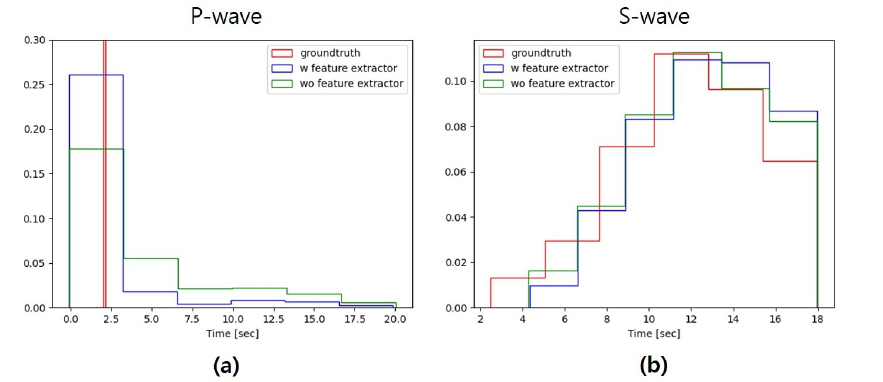
Figure 9. Comparisons of the picked arrival times distribution in the testing dataset. The blue and green histograms indicate the distributions of P- and S- wave arrival times in the synthetic seismic data generated by the architecture with or without feature extractor, respectively. The red histogram indicates those distributions in real data. ( a ) P-wave and ( b ) S-wave.